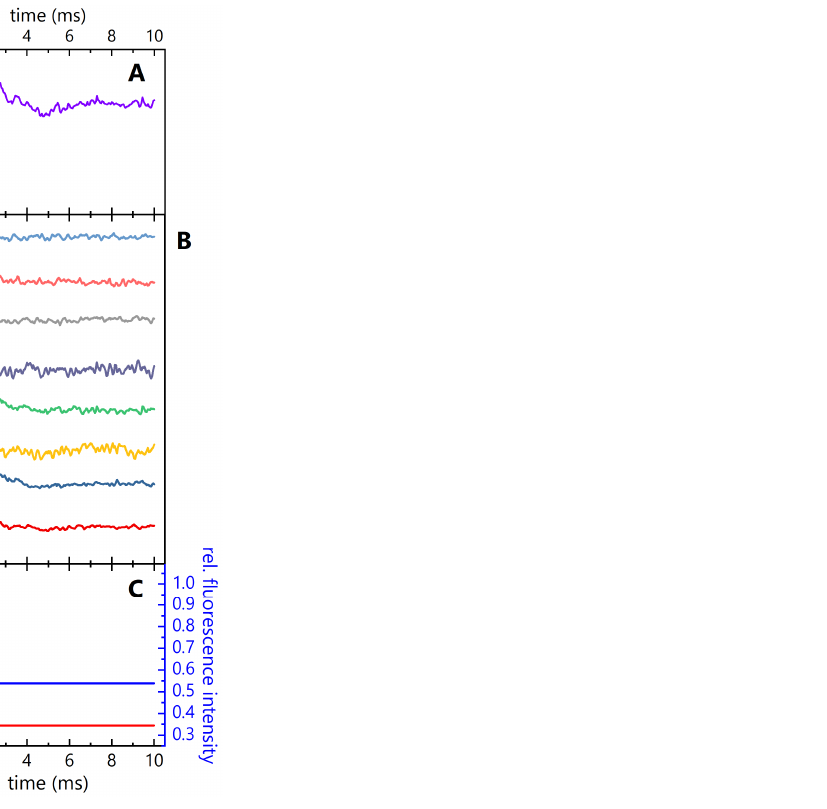
Figure 7. A comparison between fluorescence intensity traces obtained in stopped-flow self-quench- ing experiments on DPPC liposomes comprising 0.0018 mol% F12 NR 4 nanorings [10] and calculated data based on the reported permeability of F12 NC 4 in DPPC. ( A ) Shown is the exemplary trace